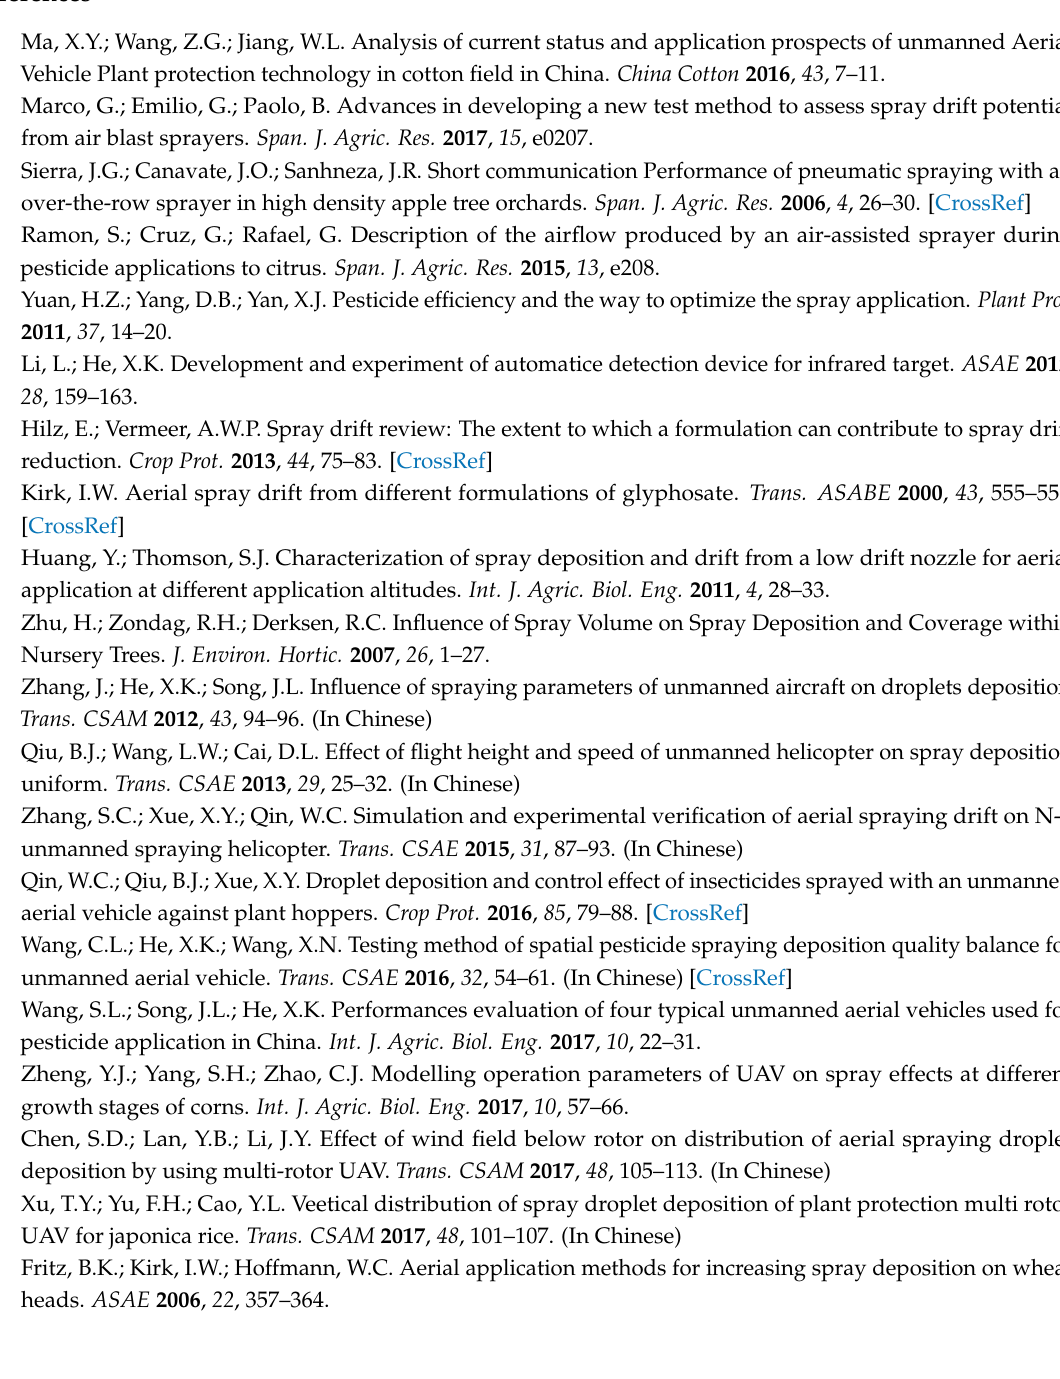
Table S1: Weather conditions during the test